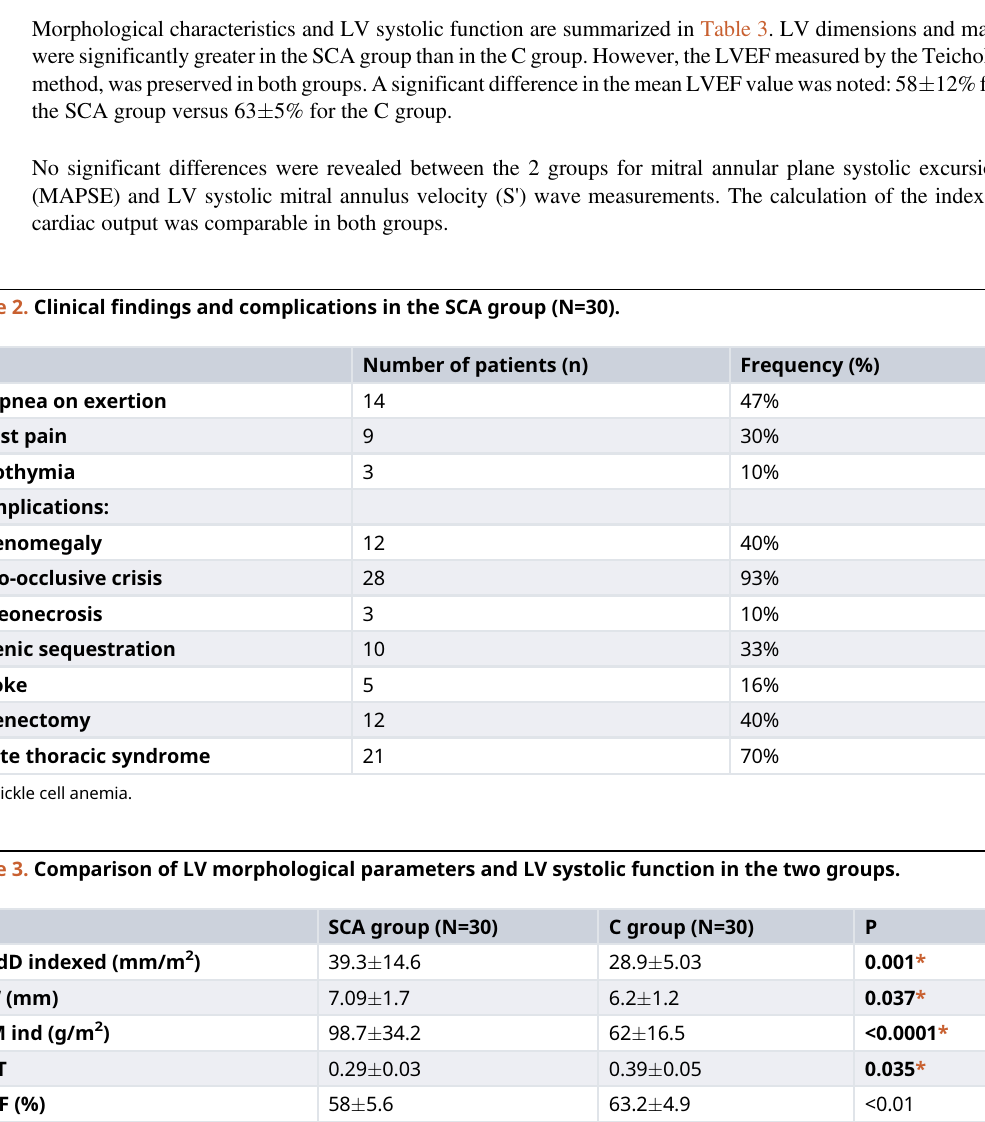
SCA: Sickle cell anemia group, C group: Control group, LVtdD: Telediastolic diameter of the left ventricle, ISW: interseptal wall, LVMind: Indexed left ventricular mass, RWT: Wall Relative Thickness, LVEF: Left ventricular ejection fraction, S ’ : Systolic mitral annulus velocity in DTI, MAPSE: Mitral annular plane systolic excursion.